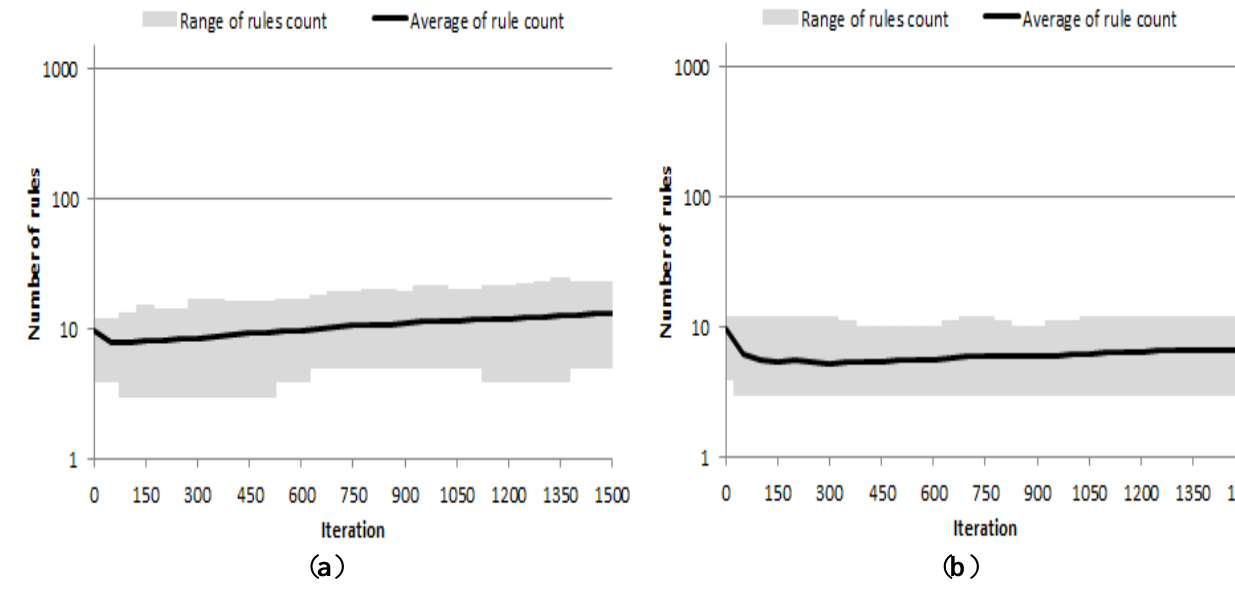
Figure 9. Range of rule count by iteration ranking images using Associative & Genetic method on the ( a ) UCI Statlog Landsat and ( b ) WROX data